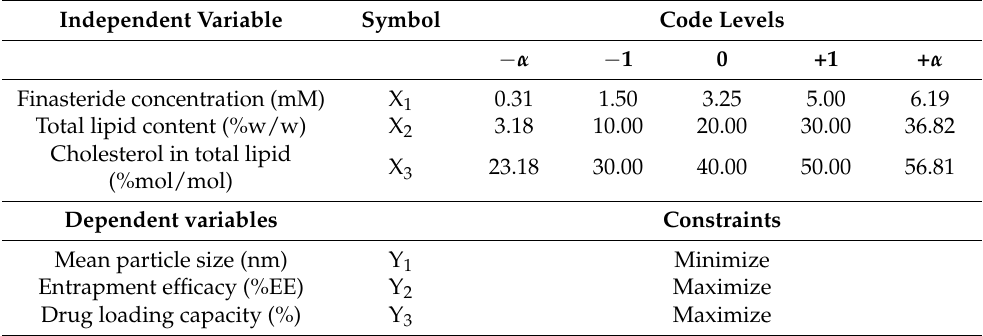
Dependent variables Constraints Mean particle size (nm) Y 1 Minimize Entrapment efficacy (%EE) Y 2 Maximize Drug loading capacity (%) Y 3